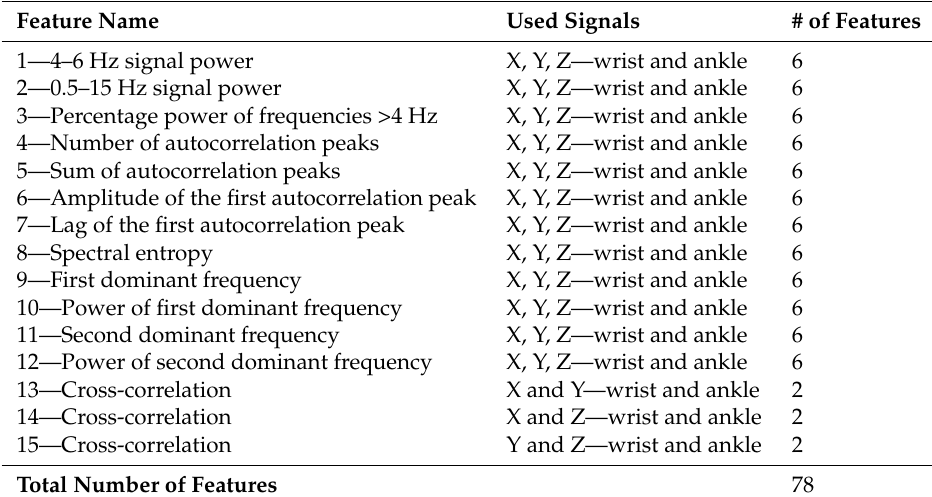
Table 2. The extracted features in this